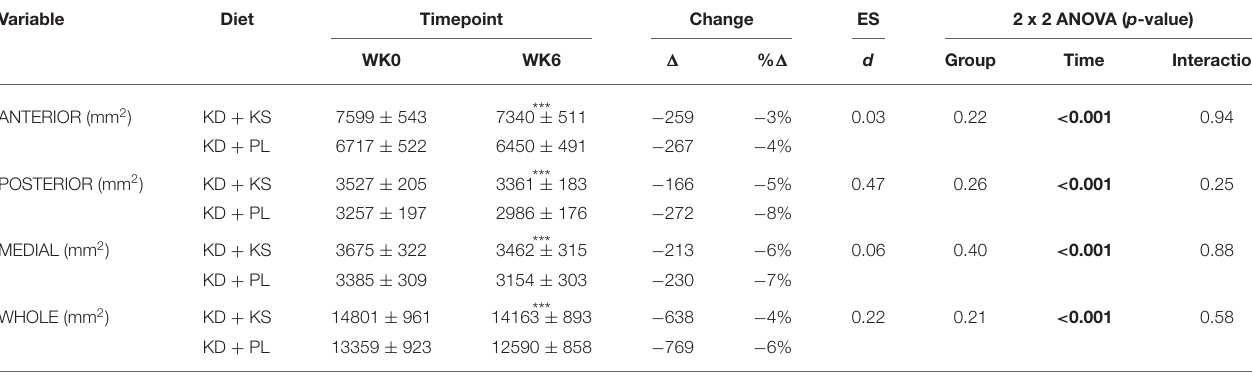
TABLE 4 | Mid-thigh cross-sectional area. Variable